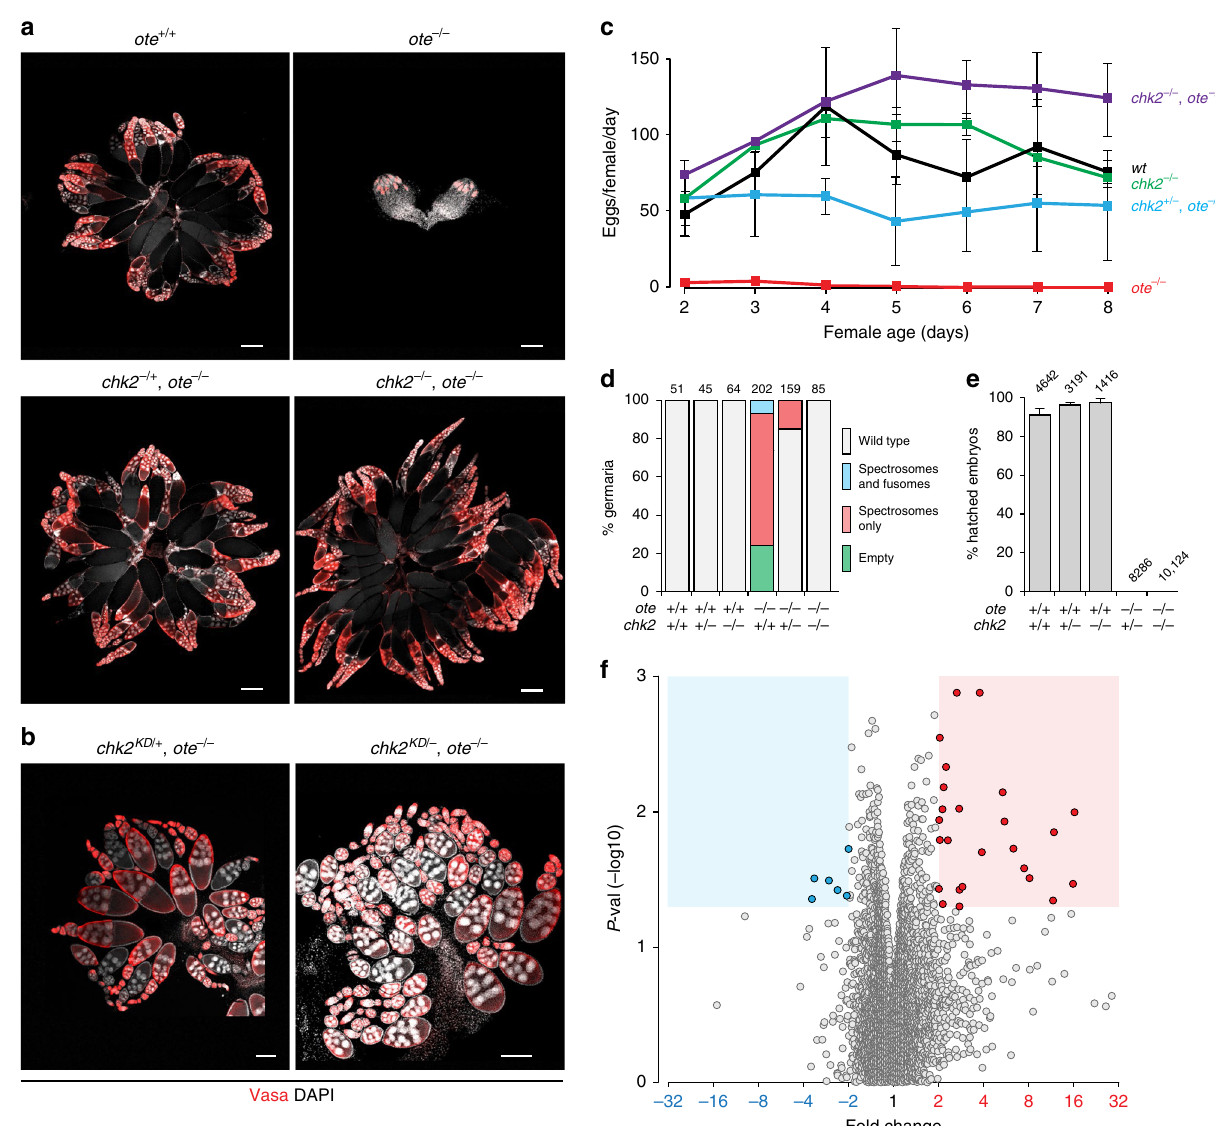
Fig. 2 Chk2 activation is responsible for oogenesis defects in ote mutants. a , b Confocal images of ovaries dissected from less than 2-day-old females stained for Vasa (red) and DAPI (white). Genotypes are noted on the top of each image, wherein ote − / − corresponds to ote B279G/PK . The chk2 - alleles were either deletion alleles ( a ) or a kinase dead allele (Table S1, b). Scale bars represent 250 µ m ( a ) or 100 µ m ( b ). c Fecundity (eggs per female per day) of females mated to ote + / + males as a function of female age in days. Bars indicate the standard deviation from a minimum of three independent experiments, assaying 7 – 15 females each time. Genotypes are noted to the right of each line. d Quanti fi cation of germarial phenotypic classes, as described on the right 12 . Genotypes are listed below the corresponding bar, with the number of germaria scored listed at the top. e Percentage of eggs that hatched within 48 h following deposition by females that were mated to ote + / + males. Bars represent the standard deviation from at least two independent experiments. The number of eggs analyzed is noted above each bar. f Volcano plot of gene expression microarray results. The x -axis shows fold change between NULL ( chk2 P6 , ote PK / ote B279G and ote PK / chk2 P30 , ote B279G ), and HET ( chk2 P6 , ote PK / CyO and chk2 P30 , ote B279G / CyO ) ovaries and the y -axis shows one-way ANOVA p value; areas corresponding to twofold change cutoff and p < 0.05 are shaded, points corresponding to signi fi cantly decreasing or increasing RNAs are colored blue and red,